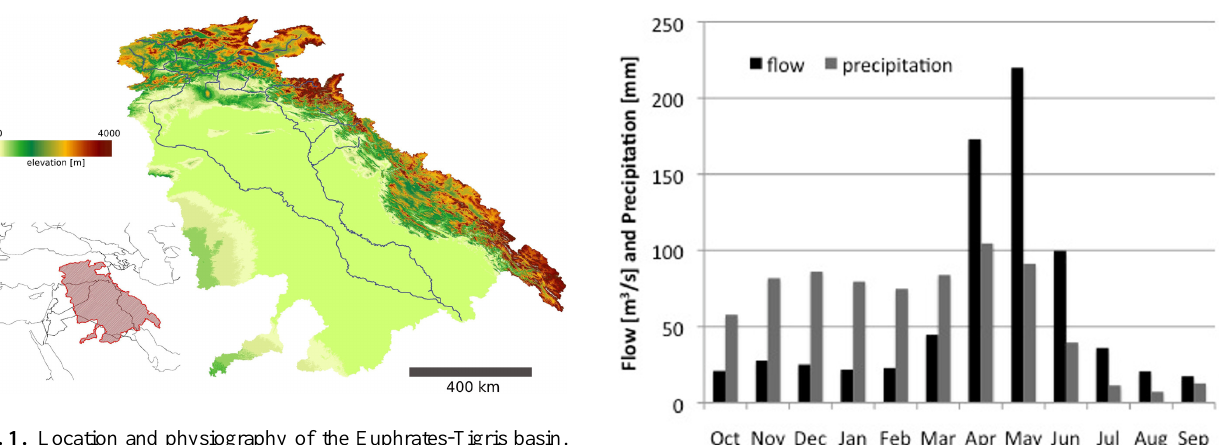
Fig. 1. Location and physiography of the Euphrates-Tigris basin. The location of each river course is also shown. The high elevation zones flanking the north and east of the basin forms the shape of the Fertile Crescent.